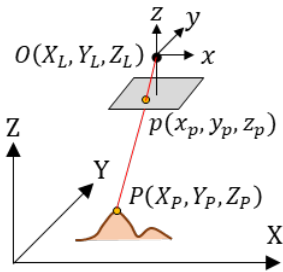
Figure 2. Geometric relationship between ground point, image point, and perspective center.